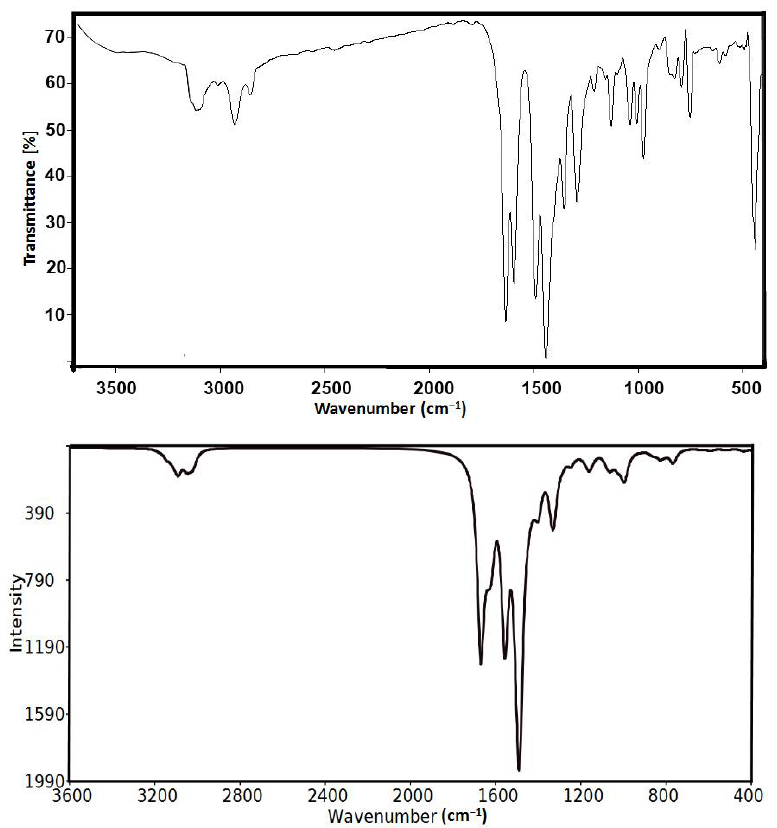
Figure 9. The experimental (upper) and calculated (lower) vibrational spectra of complex 2 .